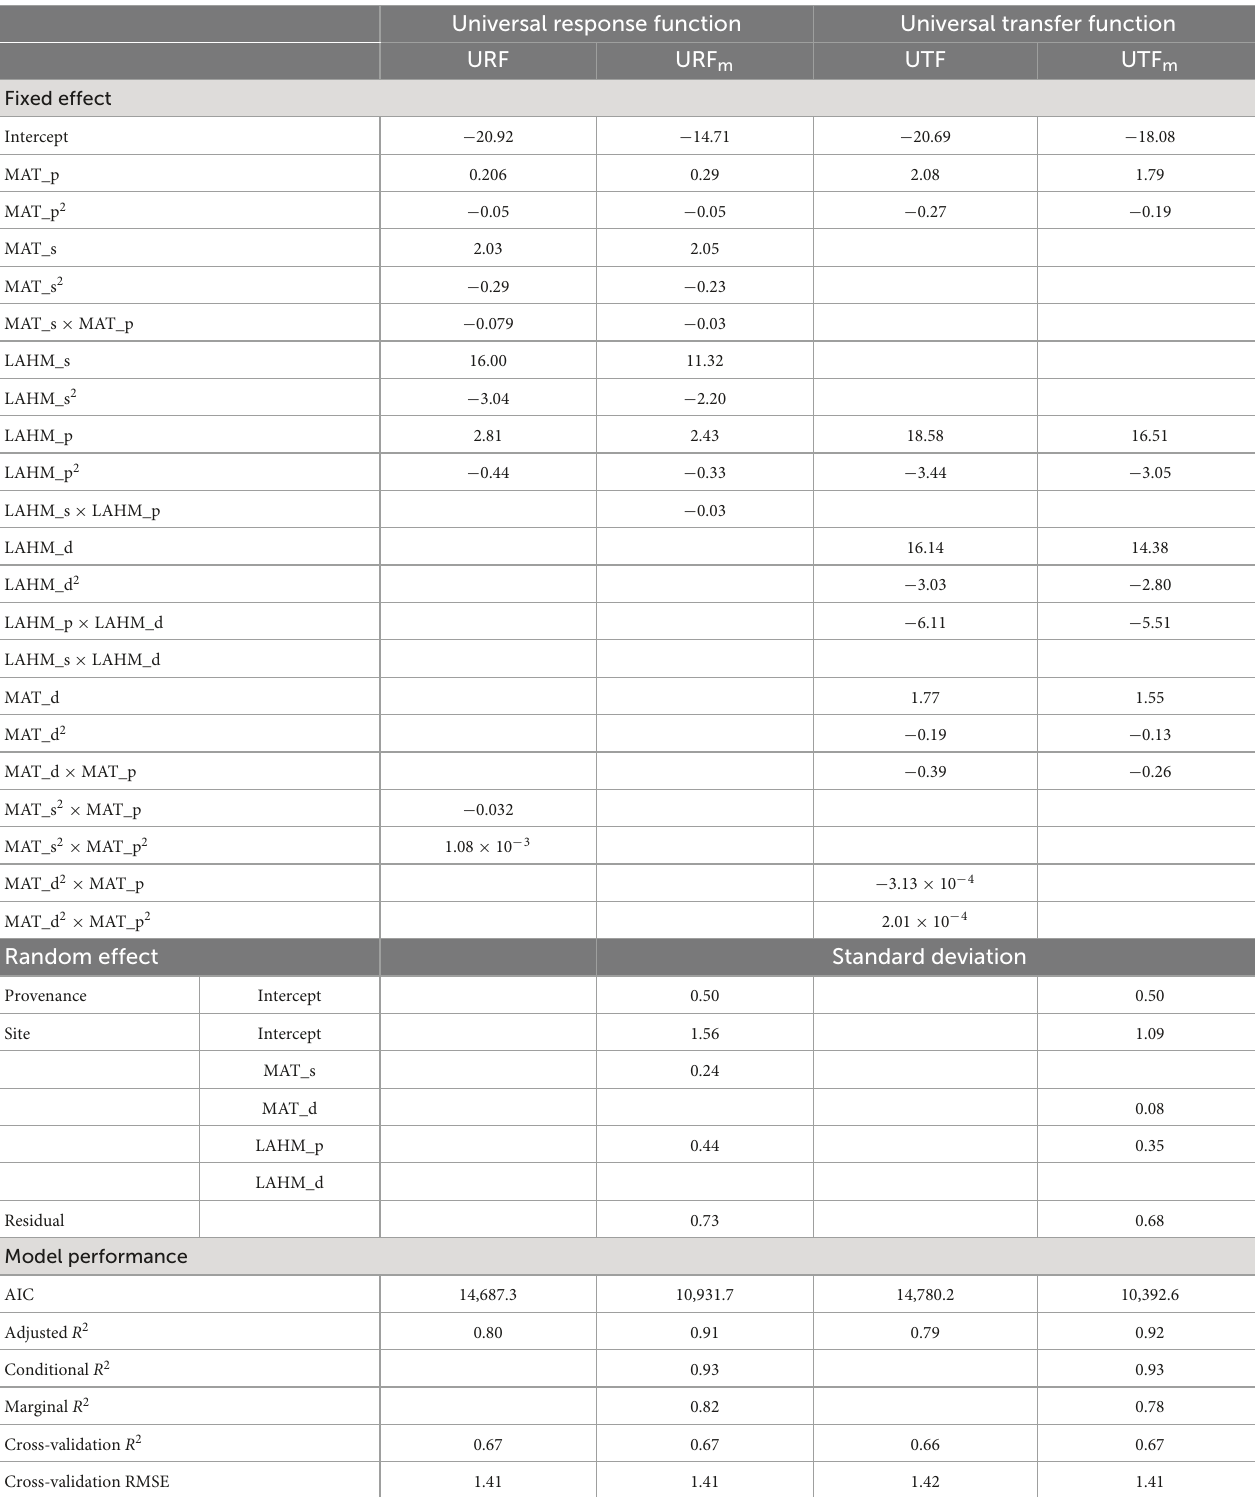
TABLE 2 Parameter estimates and model performance statistics for multiple regression universal response function (URF), universal transfer functions (UTF), and their mixed-effect models (URF m and UTF pdm